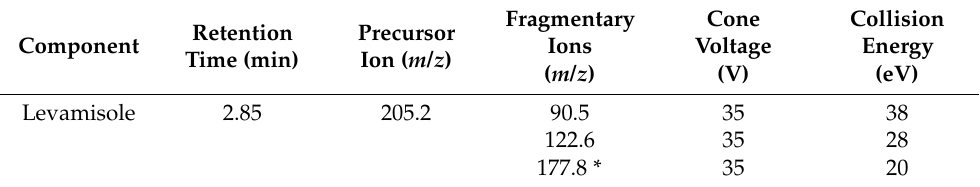
Table 2. Retention time and MS/MS parameters for